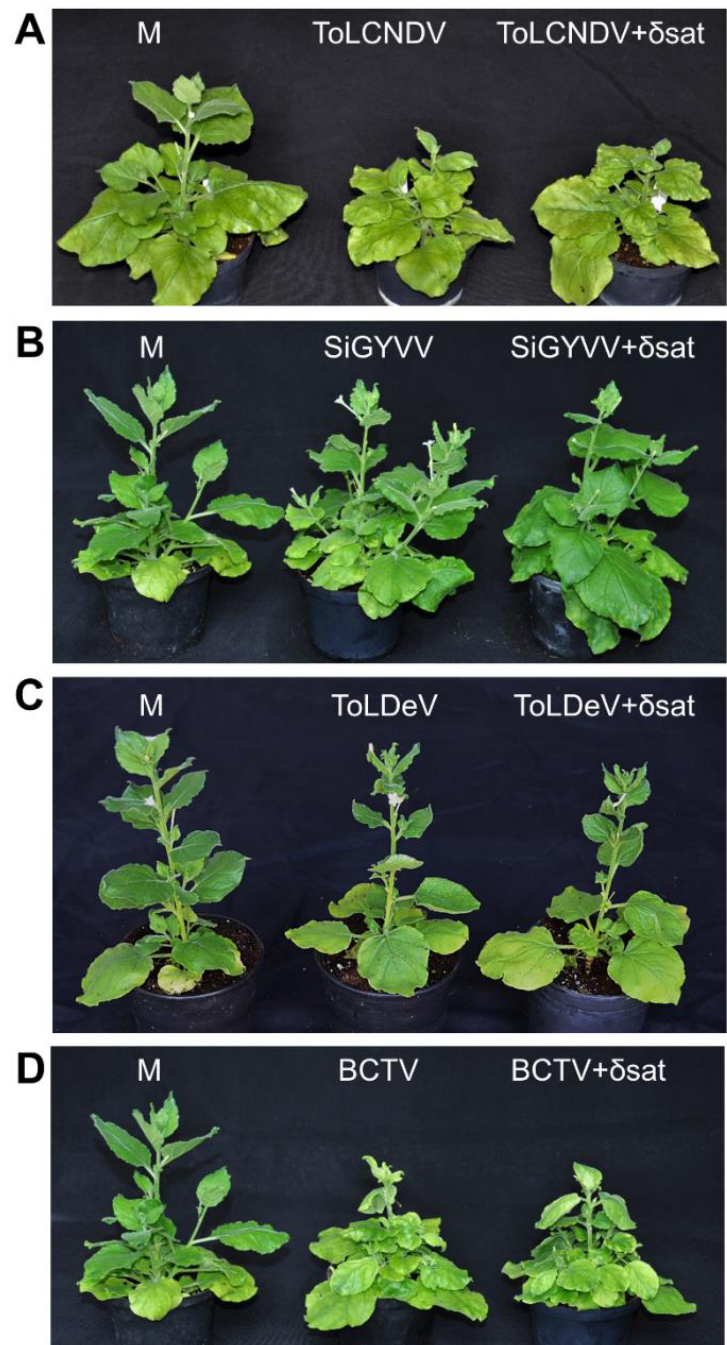
Figure 5. Symptoms caused by ( A ) tomato leaf curl New Delhi virus (ToLCNDV), ( B ) Sida golden yellow vein virus (SiGYVV), ( C ) tomato leaf deformation virus (ToLDeV), and ( D ) beet curly top virus (BCTV) alone or in combination with sweet potato leaf curl deltasatellite 1 (δsat) on agroinoculated Nicotiana benthamiana plants. Mock-inoculated plants (M) are shown at the left of each panel. Photographs of representative plants were taken at 30 days post-inoculation.